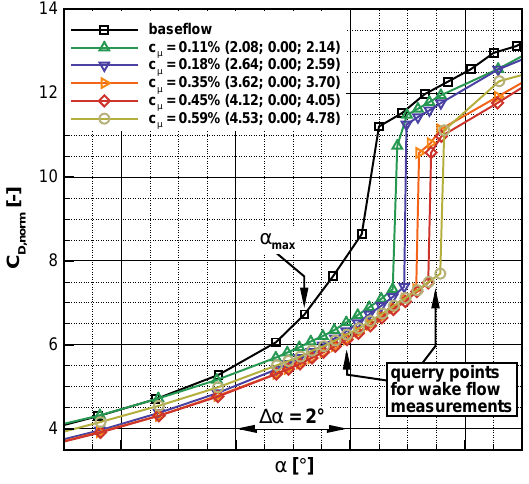
Figure 14. Drag coefficient for forcing with Segments 1 and 3 for various c µ .